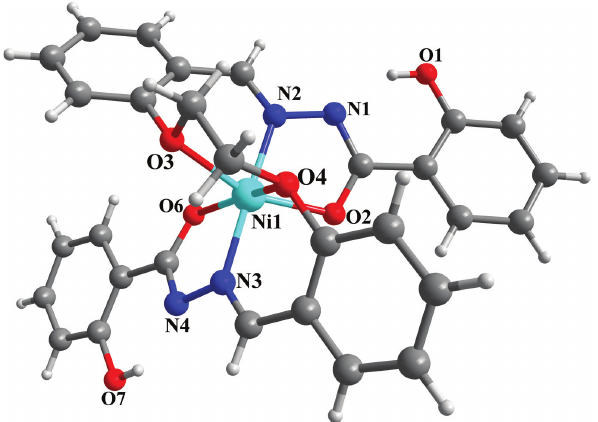
Table 2: Fractional atomic coordinates and isotropic or equivalent isotropic displacement parameters (Å 2